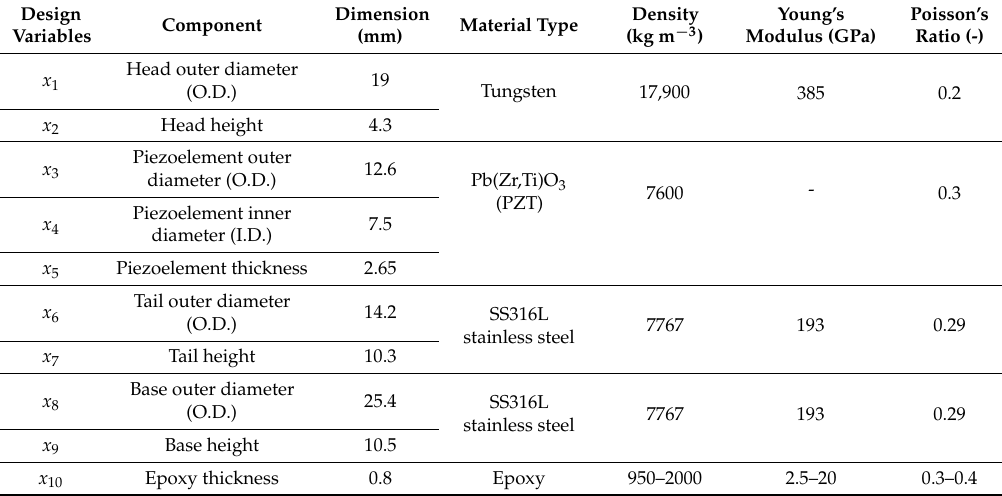
Table 1. Dimensions, material type, and mechanical properties (i.e. density, Young’s modulus, and Poisson’s ratio) for each